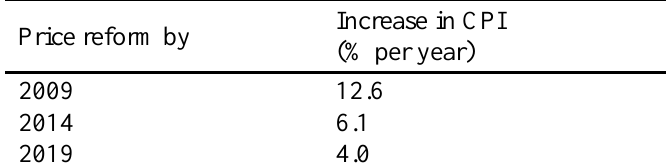
Table 5. Effect on Consumer Price Index (CPI) of price